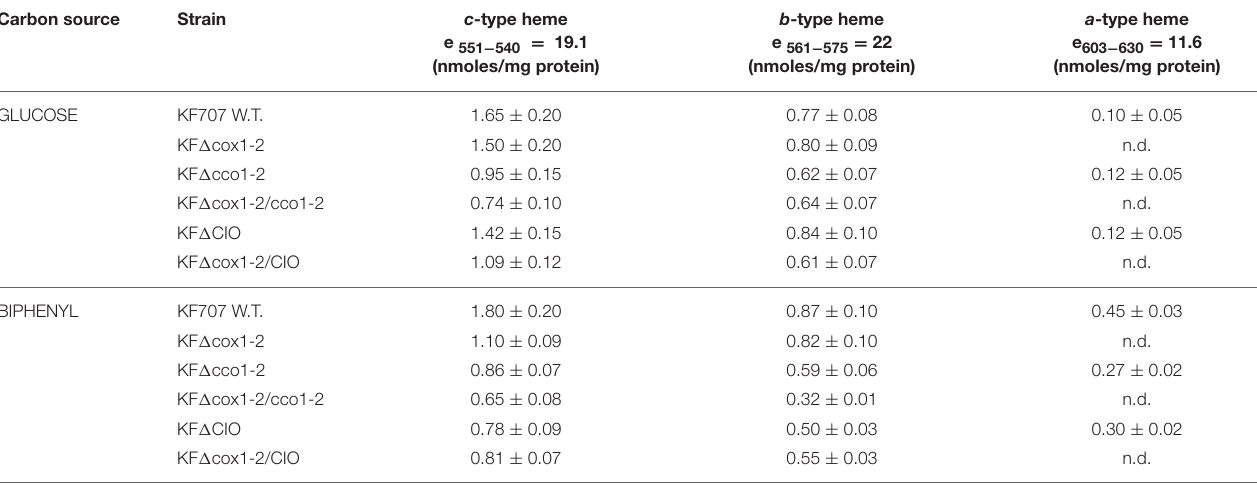
TABLE 2 | Heme amounts of a -, b -, and c -type in membranes isolated from KF707 W.T. and oxidase mutant cells grown with glucose and/or biphenyl as unique carbon source. Carbon source